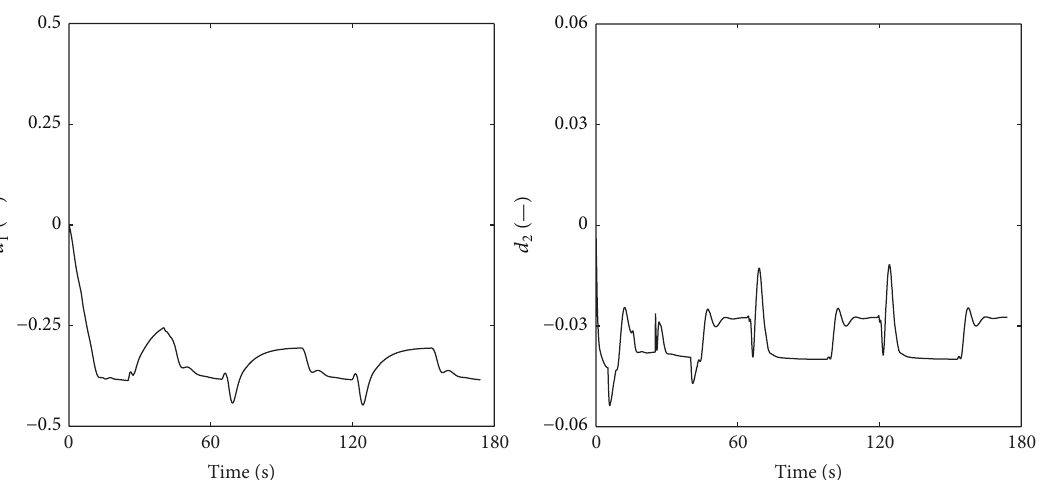
Figure 9: Estimated disturbances of the longitudinal controller in the simulation with reduced power and